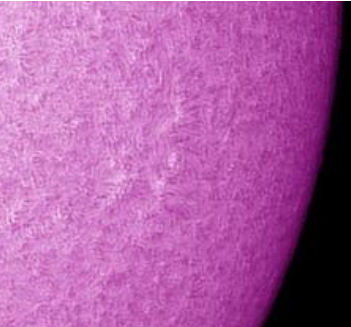
Figure 15. Close-up of Solar Limb in Calcium-K